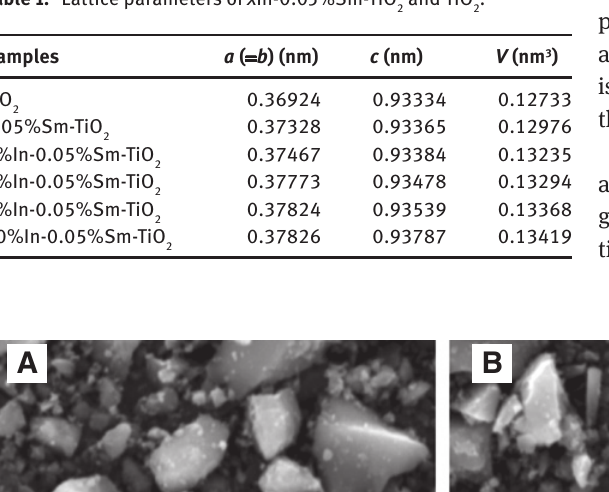
, (B) 1%In-0.05%Sm-TiO 2